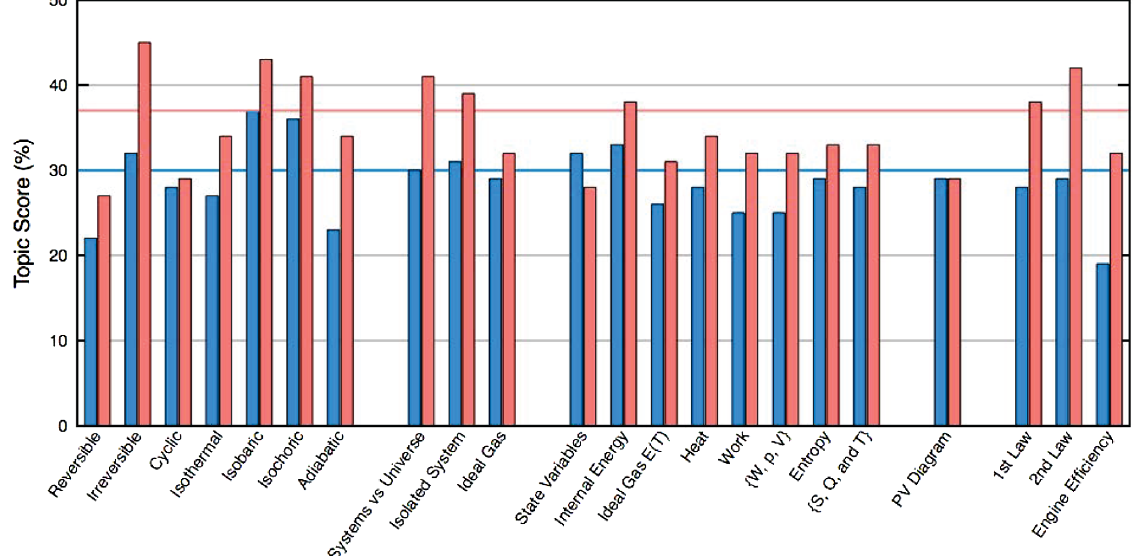
respectively.FIG. 3. Average percentage scores for students in algebra-based introductory physics courses on the STPFaSL instrument by topic before and after instruction (for the pretest, the number of students N ¼ 218 , blue, and for the post-test, N ¼ 382 , red). The blue and red horizontal lines show the averages on the entire survey instrument before and after instruction,